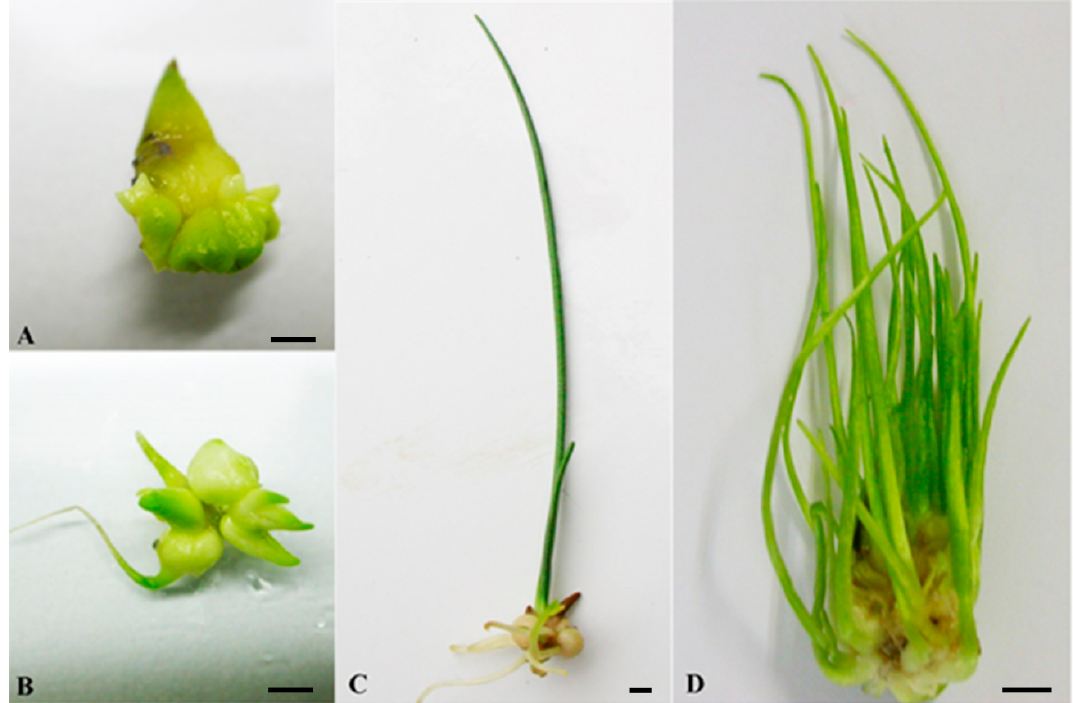
Figure 1. Different stages of in vitro bulb development in F. meleagris depending on temperature regime. ( A ) Dormant bulb regenerated on MS medium (4 weeks at 24 °C). ( B ) Sprouted bulb after cold pretreatment (4 weeks at 4 °C). ( C ) Rooted bulb after dormancy release, cultured at 24 °C after cold pretreatment. ( D ) Shoot multiplication, at 24 °C after cold pretreatment. Scale bars = 3 mm.